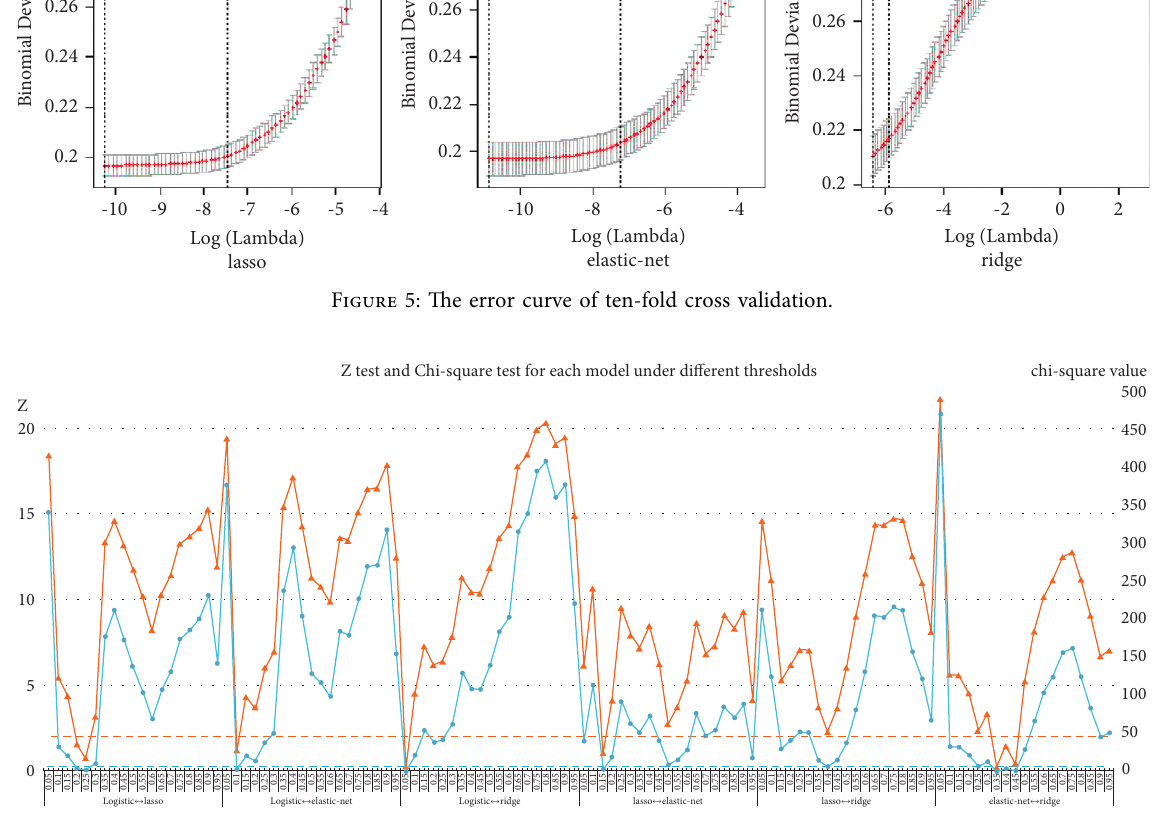
Figure 6: Comparison of VM instance